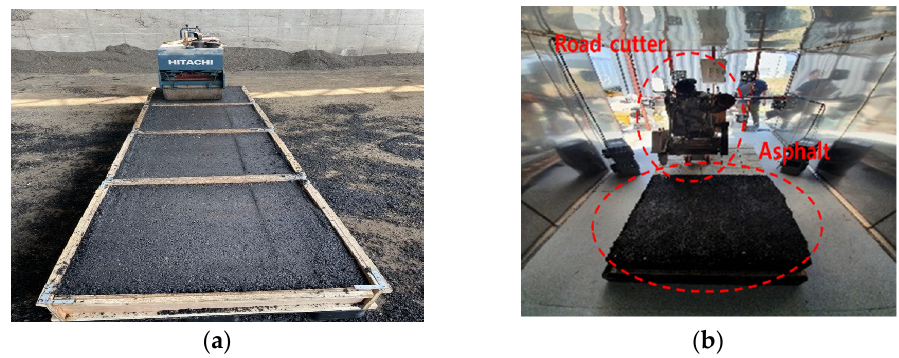
Figure 6. ( a ) Preparation of asphalt concrete specimen and ( b ) chamber experimental setup.